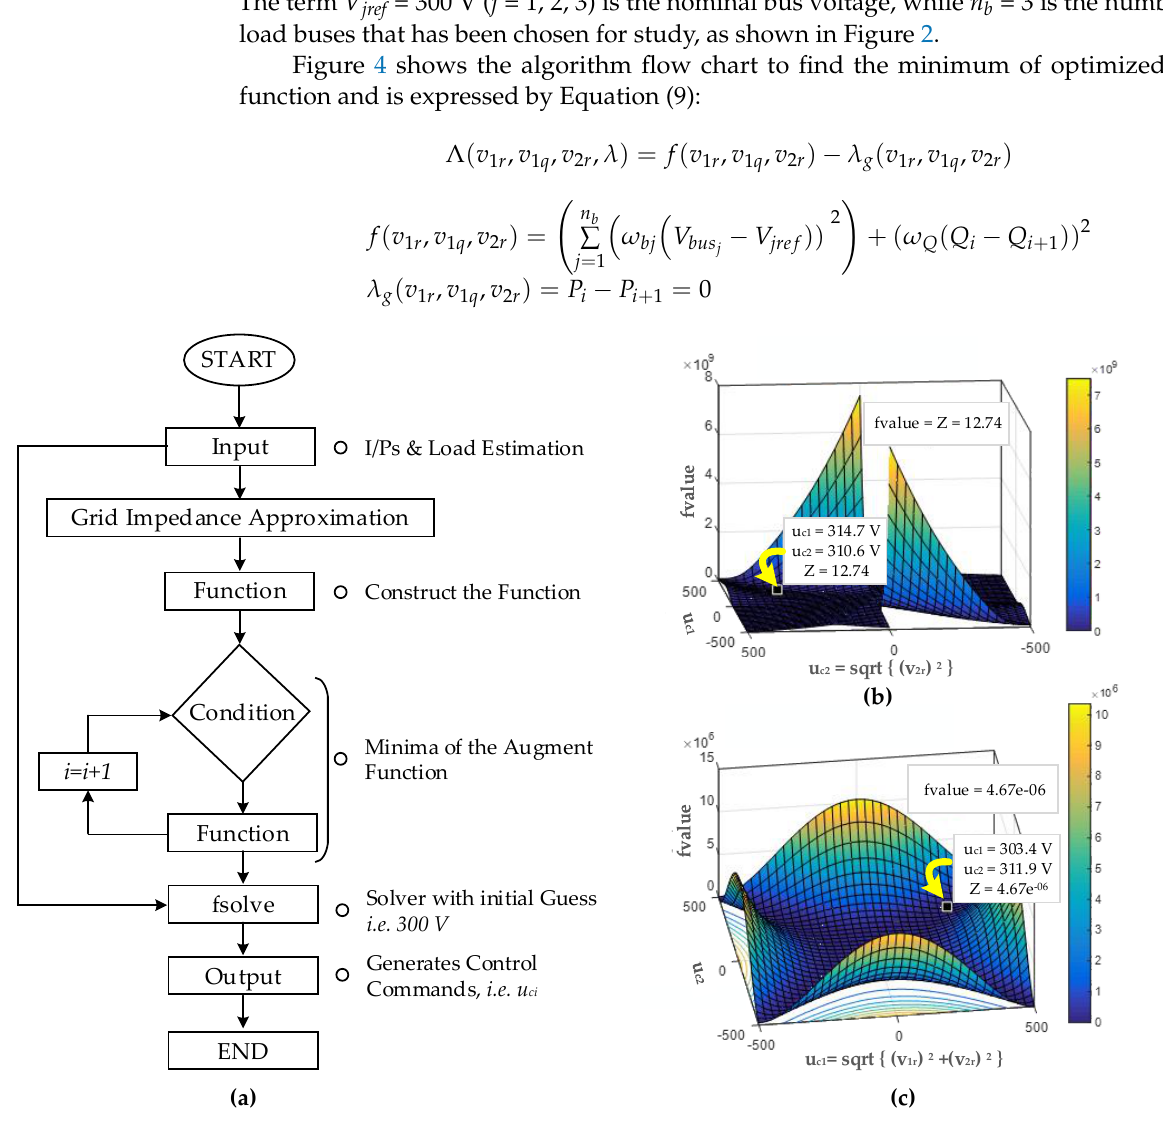
Figure 4. ( a ) MG optimal regulator’s algorithm flowchart; ( b ) and ( c ) shows surface plots (3D) of minima (i.e., fvalue) and optimal control commands ( u c1 , u c2 ) at different disturbance load.